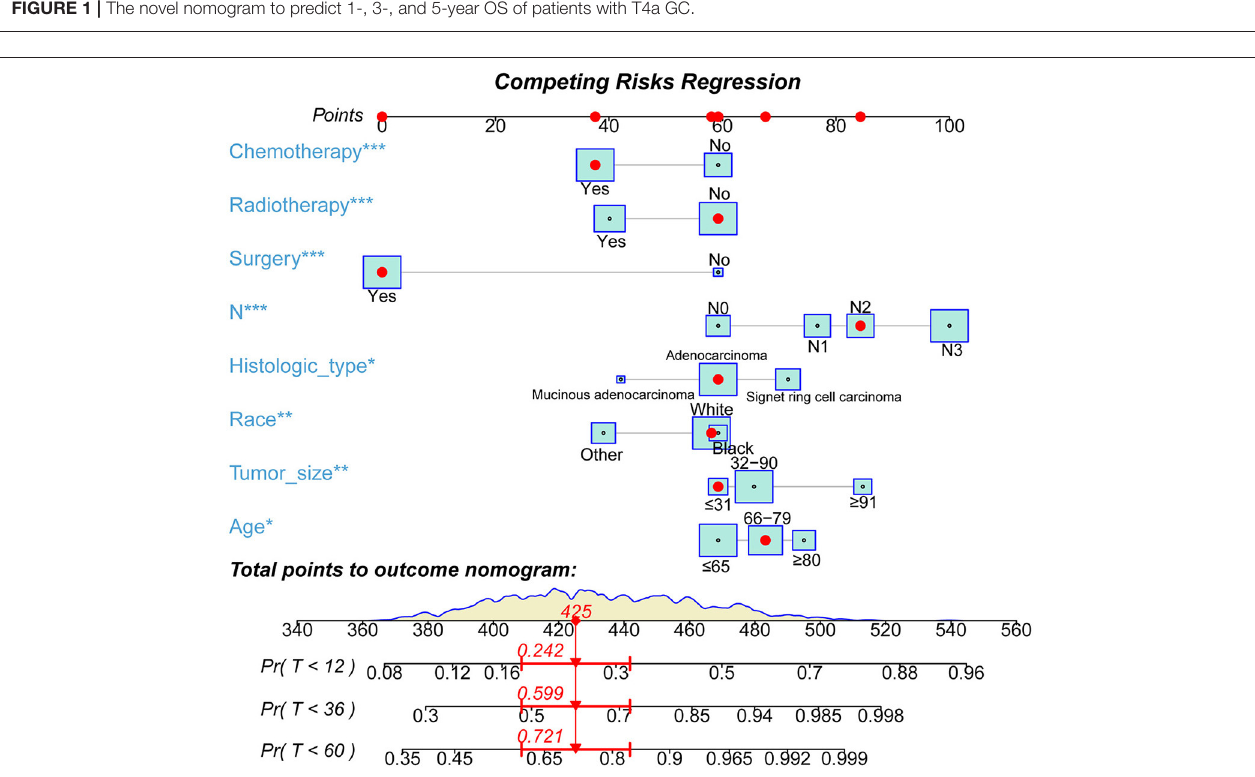
FIGURE 2 | The novel nomogram to predict 1-, 3-, and 5-year CSS of patients with T4a GC.